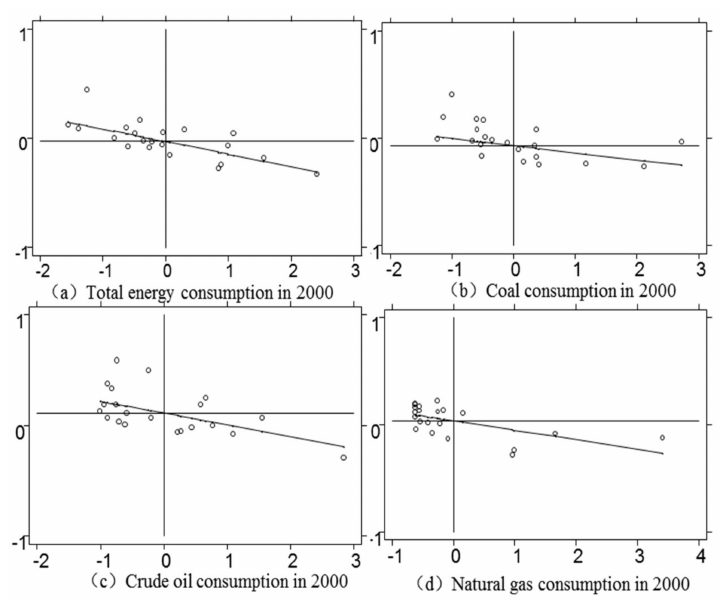
Figure 1. 2000 local Moran scatter.